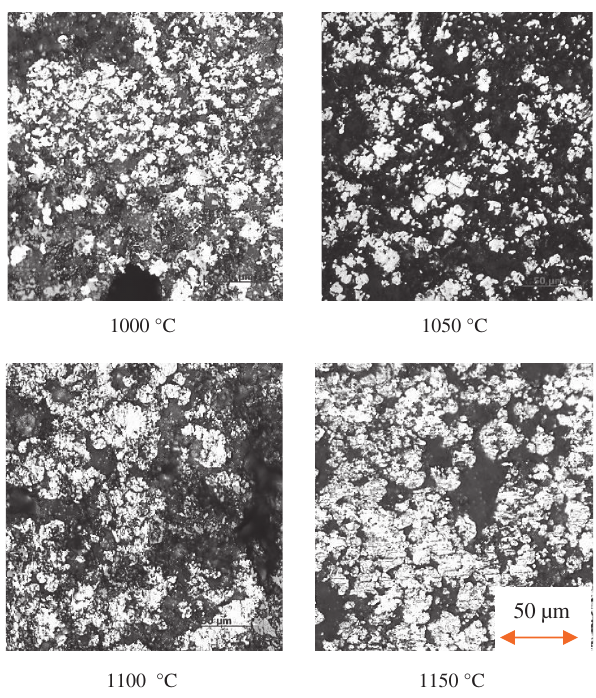
Figure 9: Microstructure of reduced pellets (bright white, metallic iron).